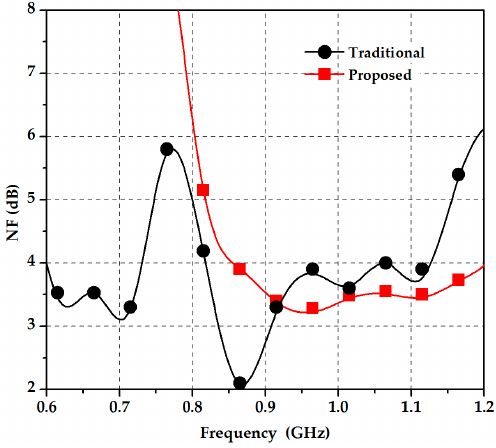
Figure 11. Measured NF (noise factor) of the traditional and proposed circuit.